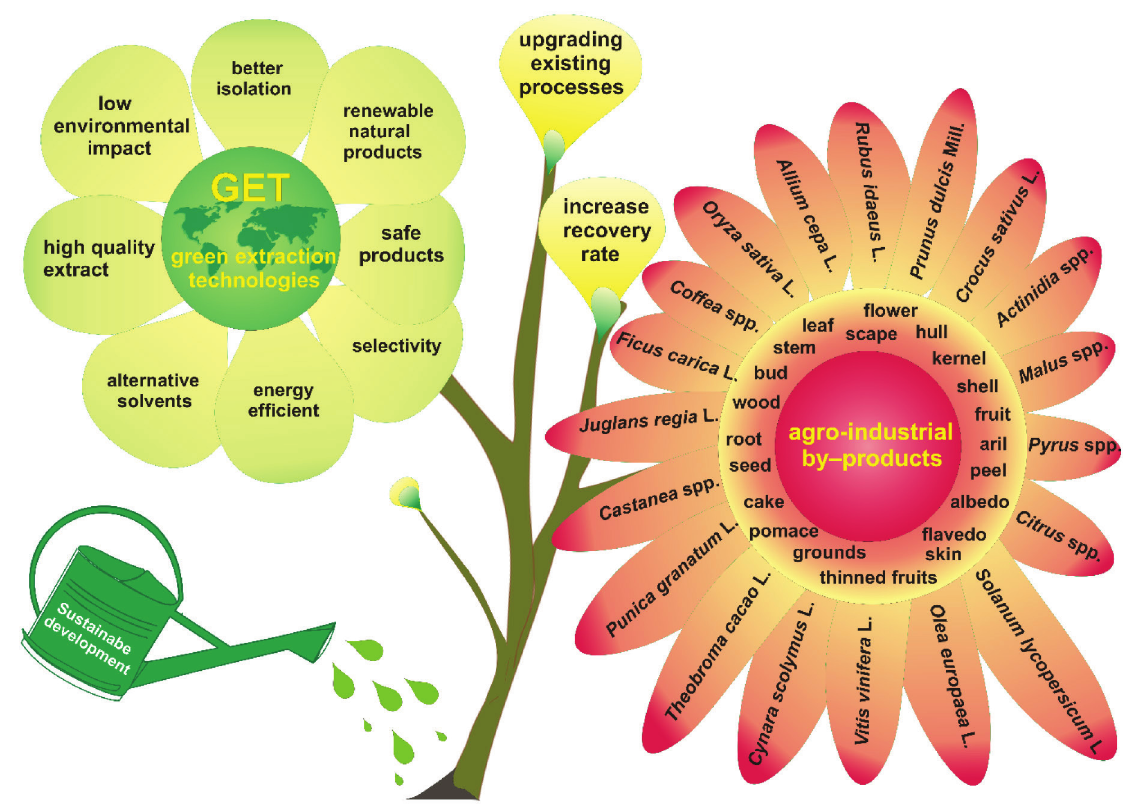
Fig. 2 – Blooming of the GETs and agro-industrial by-products’ exploitation in the framework of sustainable development (for the abbreviations, see the list at the end of the